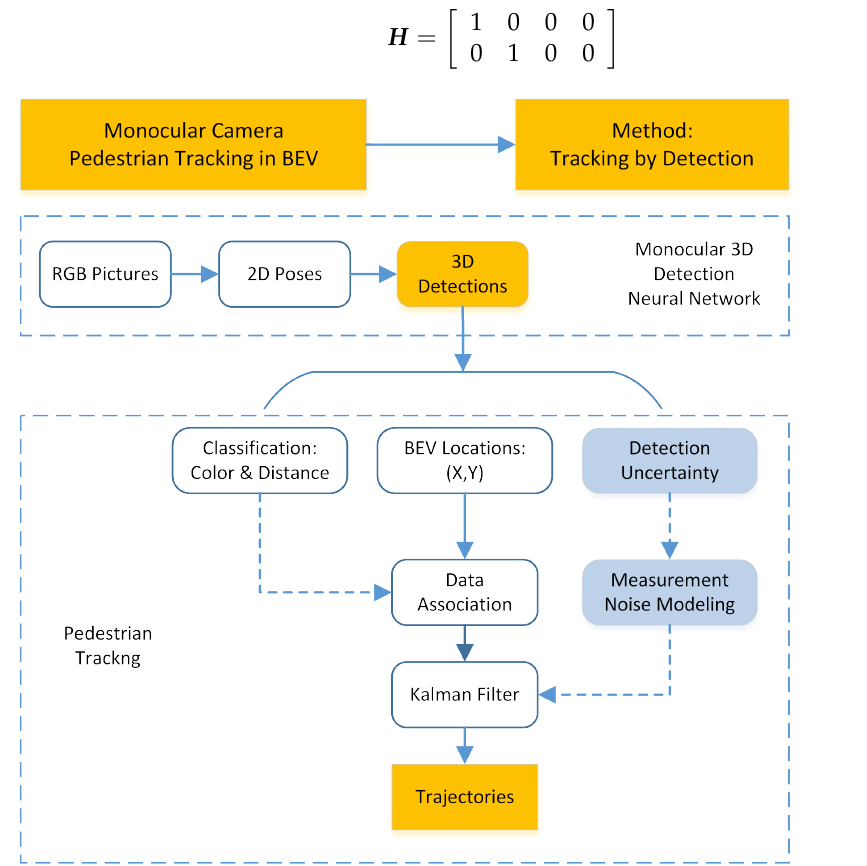
Figure 2. Monocular camera pedestrian tracking